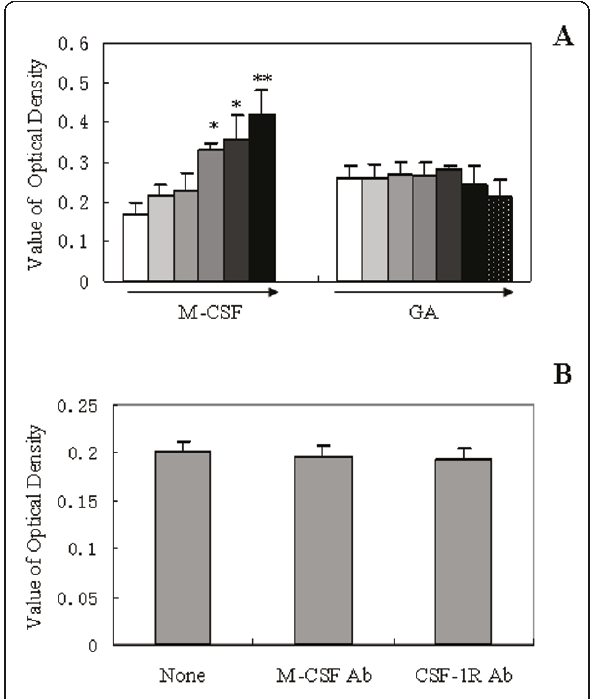
Figure 1 Effect of M-CSF, glycated albumin (GA) and the antibodies of either M-CSF(anti-M-CSF Ab)or CSF-1R(anti-CSF- 1R Ab) on microglial viability . After incubated with various stimuli such as M-CSF or GA (A), and anti-M-CSF Ab (1 μ g/ml) or anti-CSF- 1R Ab (1 μ g/ml) (B) for 24 h, the cell viability was assessed by MTT assay. The gradient concentrations of stimuli were: 5, 10, 25, 50, 100 ng/ml for M-CSF; and 10, 50, 100, 500, 1000, 2000 μ g/ml for GA. The results are shown as means ± SD of three individual experiments. Only M-CSF induced microglial proliferation in a dose-dependent manner, other agents have no effects on microglial viability. One- way ANOVA was performed, followed by post-hoc analysis. *, P < 0.05; **, P <